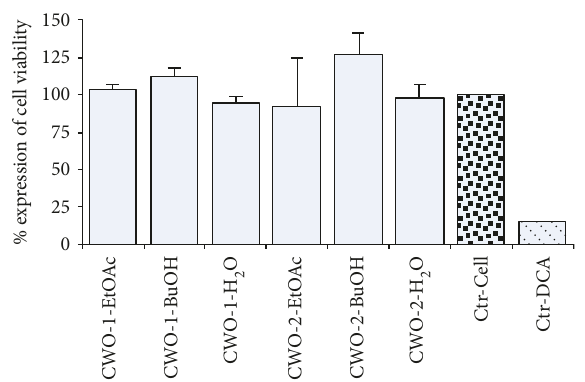
Figure 4: MTT results for cell viability of CWO-1 and CWO-2 extracts. Each extract was tested at 50 μ g/ml, and the results are presented as mean with SD displayed as positive bars ( n = 3 ). The cell viability was calculated relative to the cell control (cell media), and 500 μ M DCA was included as a positive control. MTT =thiazolyl blue tetrazolium bromide; CWO =cold- pressed whale oil; EtOAc=ethyl acetate; BuOH=butyl alcohol; DCA=deoxycholic